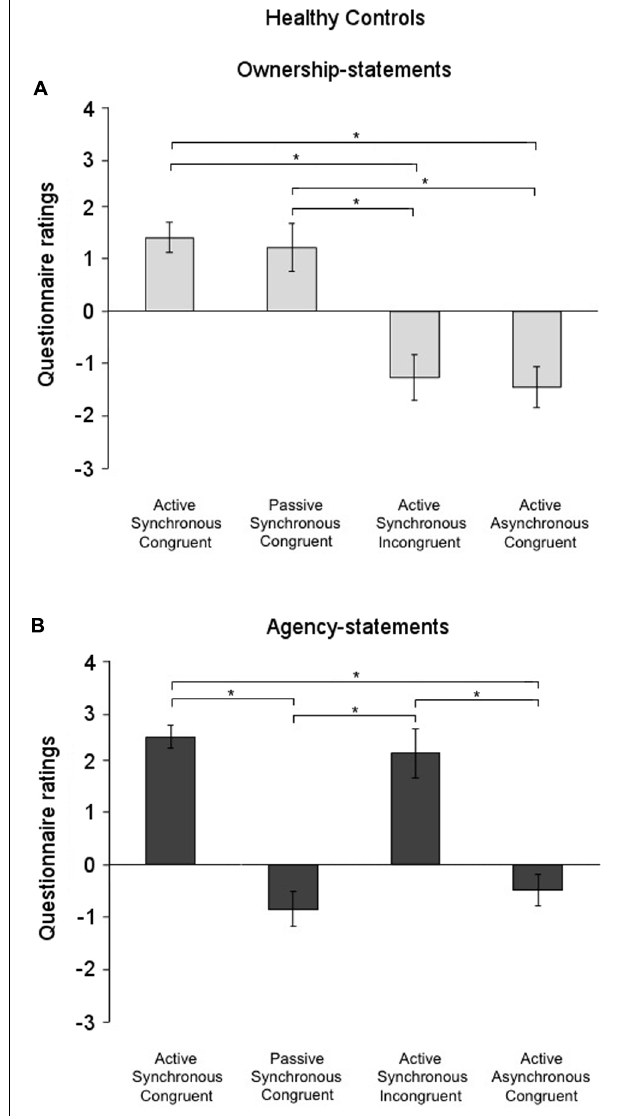
FIGURE 4 | Ownership and agency across conditions in the healthy controls group. (A) Mean scores for the ownership-statements and (B) the agency-statements across conditions in the healthy controls group. Gray lines and asterisks show significant comparisons across conditions. In the functional movement disorders group, agency and ownership were differently elicited by each condition. Error bars indicate standard